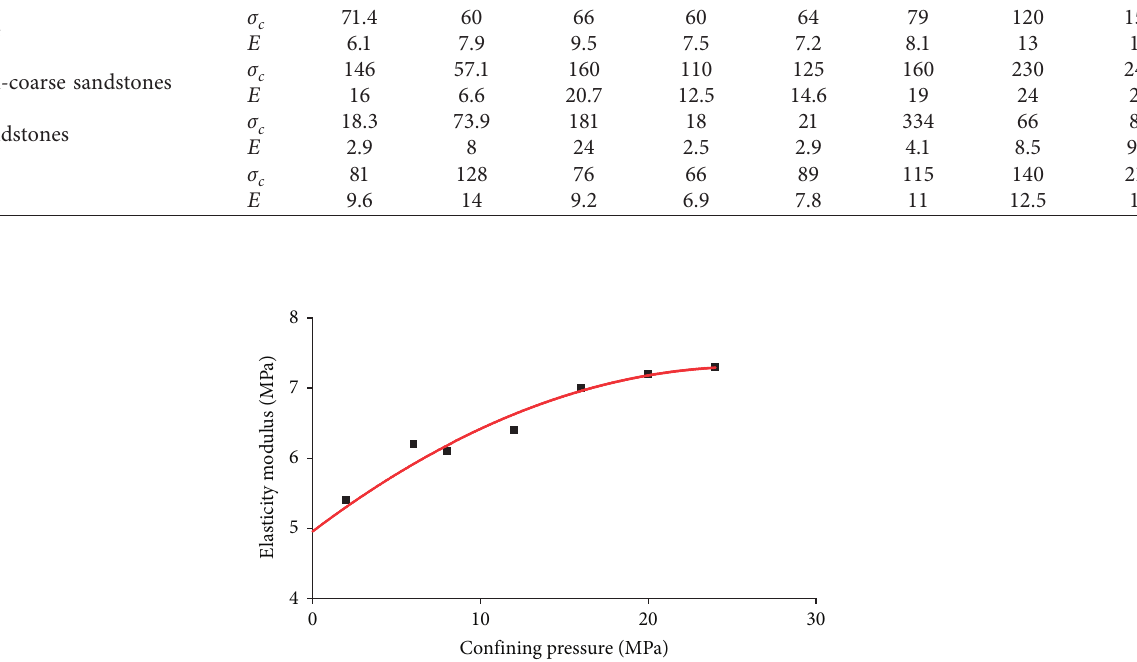
Figure 6: The relation between elastic modulus and confining pressure of coal